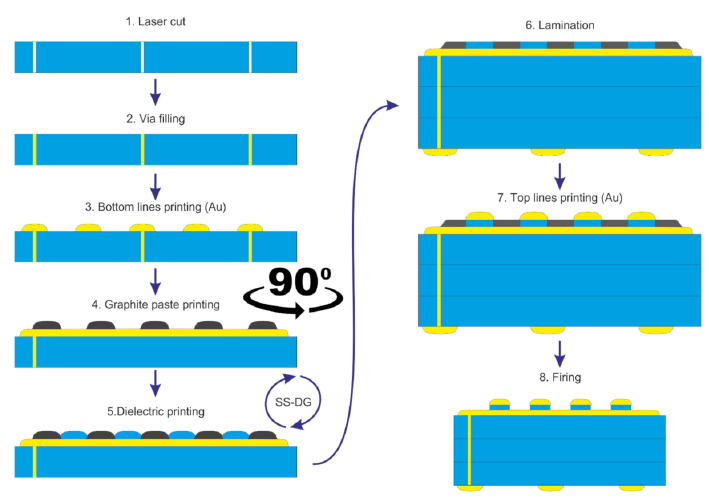
Figure 4. The manufacturing process using a screen-printed insulation